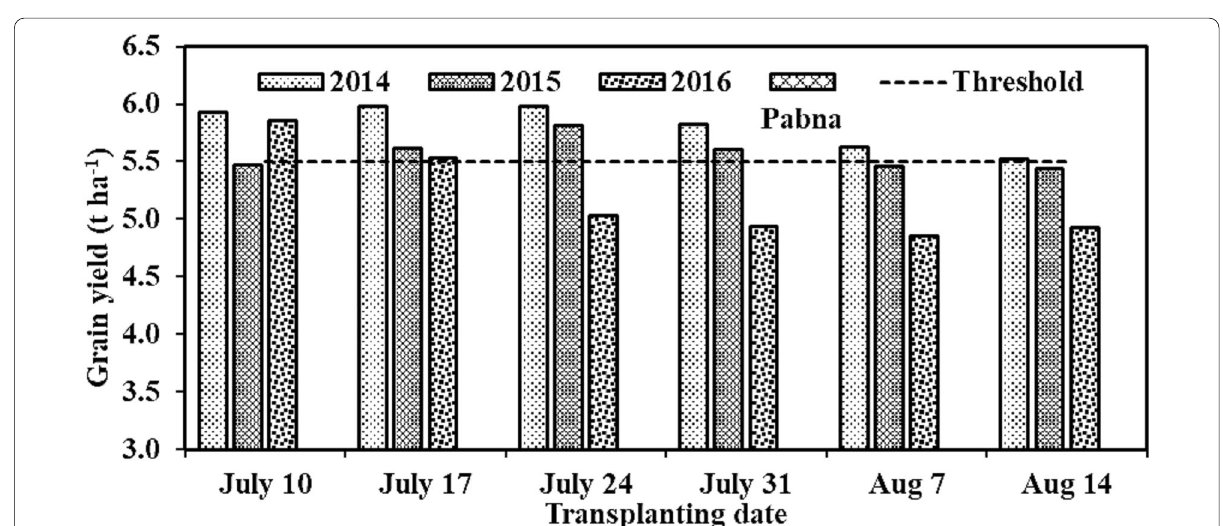
Fig. 5 Yield comparison of BR11 with threshold limit under varying transplanting date in